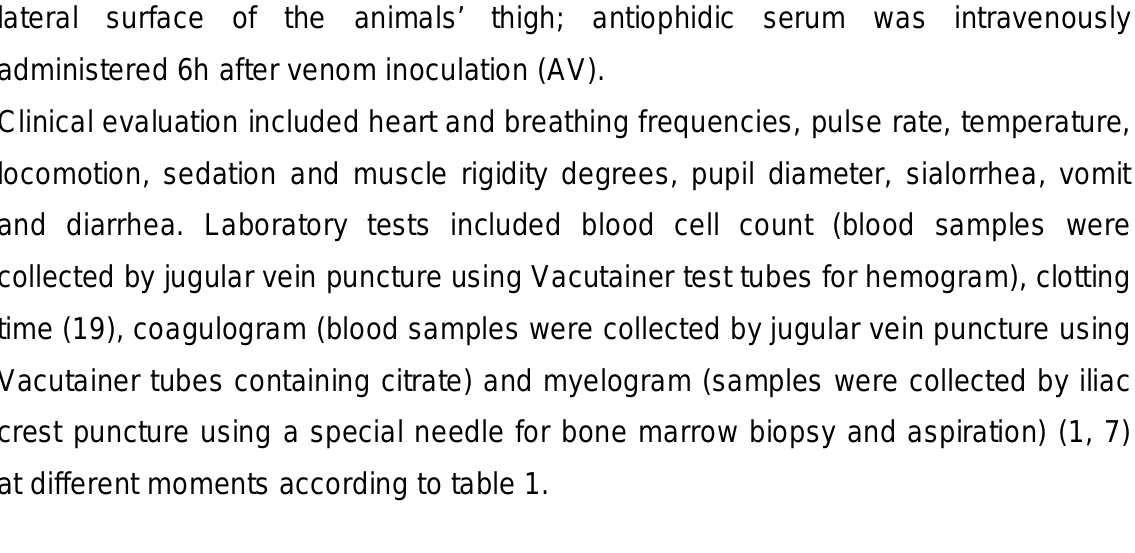
Table 1. Moments (M) of clinical evaluation and laboratory tests – blood cell count, clotting time, coagulogram and